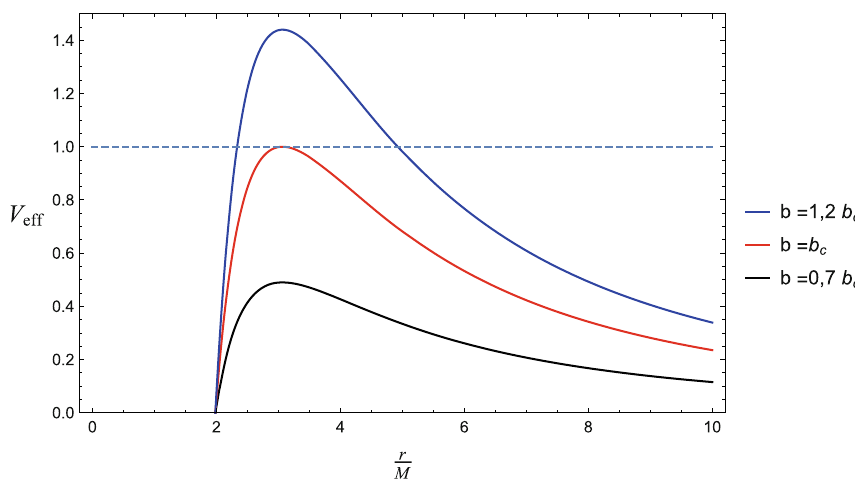
Fig. 6 V ef f for light with various value of b ( M = 1, (cid:19) = 0 . 1, κ = 10, and b c = 5 .